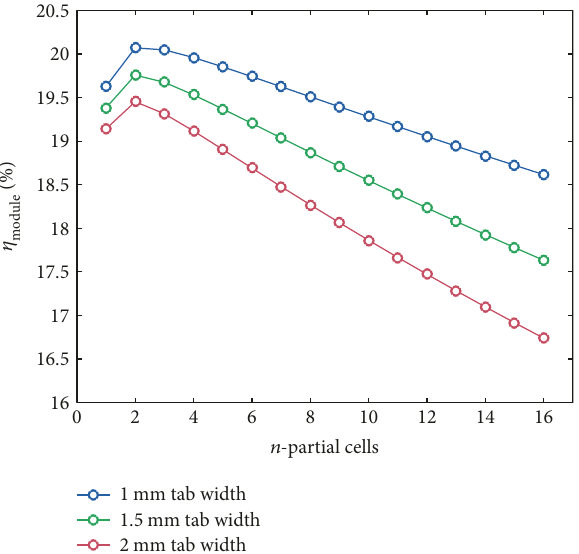
Figure 7: Area-adjusted module e ffi ciency (35 mA/cm 2 ). Figure 8: Area-adjusted module e ffi ciency (42 mA/cm 2 ).